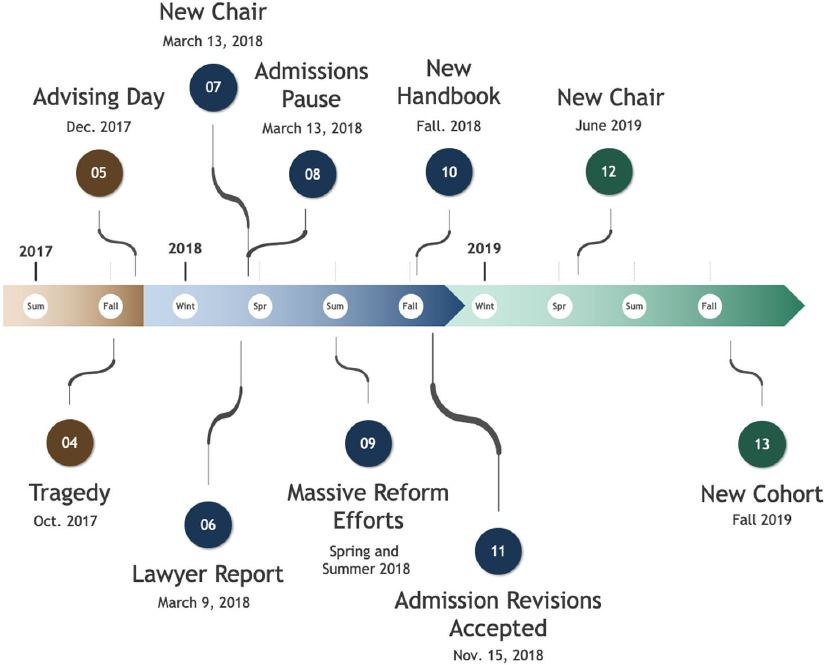
FIG. 2. Detailed timeline of change after